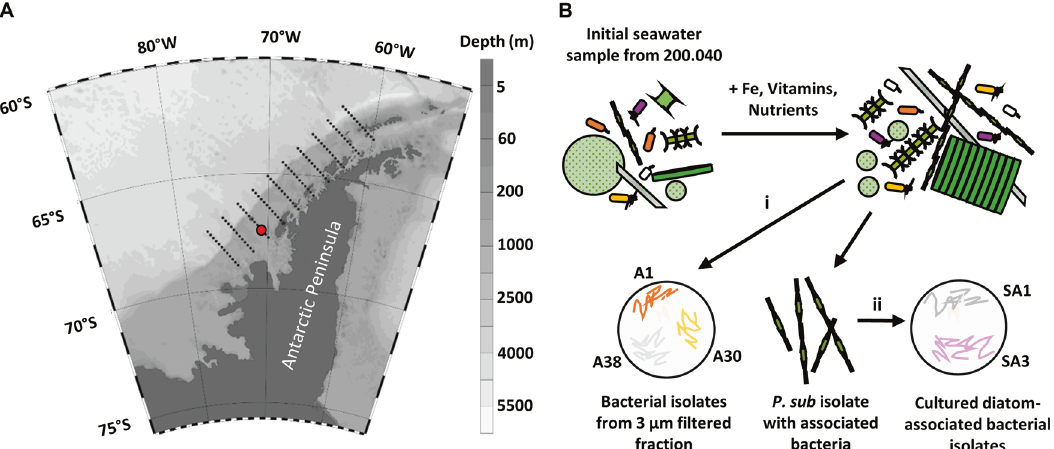
Fig. 1 Bacterial and diatom cultures were coisolated from the same SO water sample. A Map of isolation location. Black parallel dotted lines indicate LTER sampling grid at Palmer Station. Red circle is 200.040 where seawater was collected at the surface. Gradient is bathymetry in meters. B Schematic of cultivation and isolation of P. subcurvata and bacterial isolates from (i) 3 um fraction of phytoplankton enrichment culture, or (ii) closely associated with monoclonal P. subcurvata culture after passage for 12